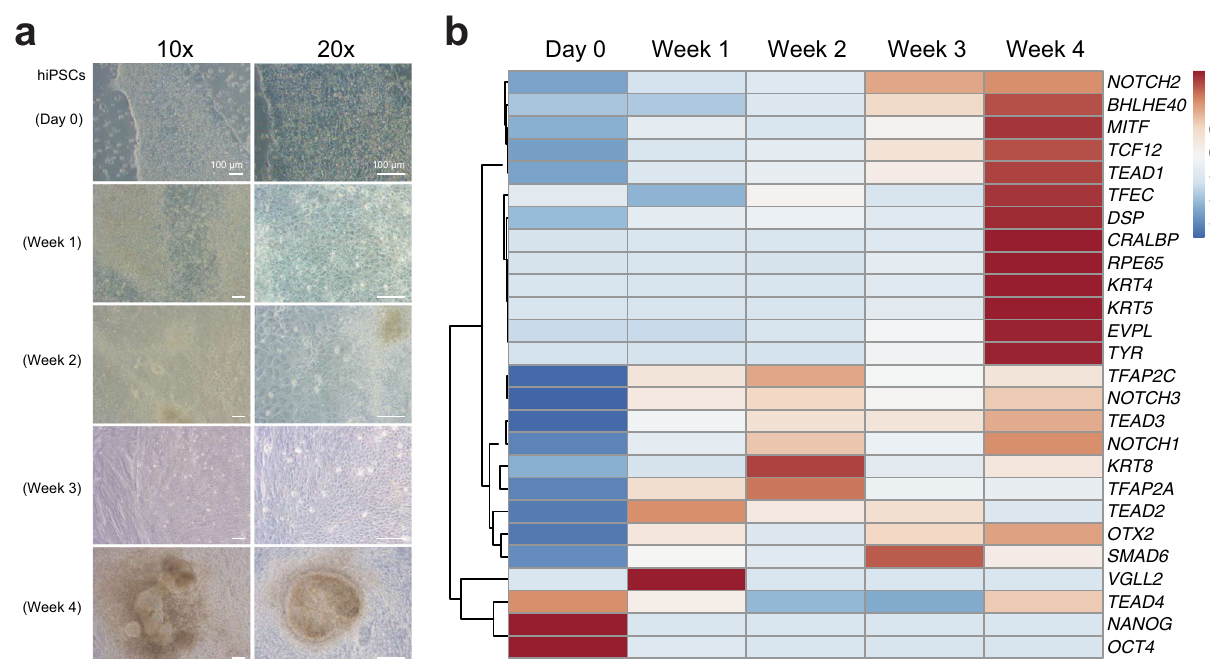
Fig. 9 Gene expression during hiPSCs-to-RPE differentiation. a Bright fi eld microscopy images (10× and 20×) of hiPSCs before (Day 0) and during their differentiation towards RPE. Note the progressive acquisition of epithelial morphology and pigmentation (observed in three independent experiments). b Hierarchical clustered heatmap showing gene expression level variations, as determined by RT-qPCR during the differentiation towards RPE from hiPSCs. Note the conservation of the two clusters (early and late transcriptional waves) identi fi ed in zebra fi